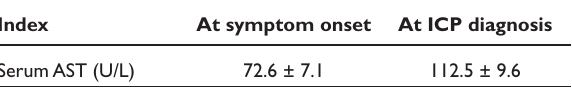
Table 2 . Serum AST level at different time points in patients with